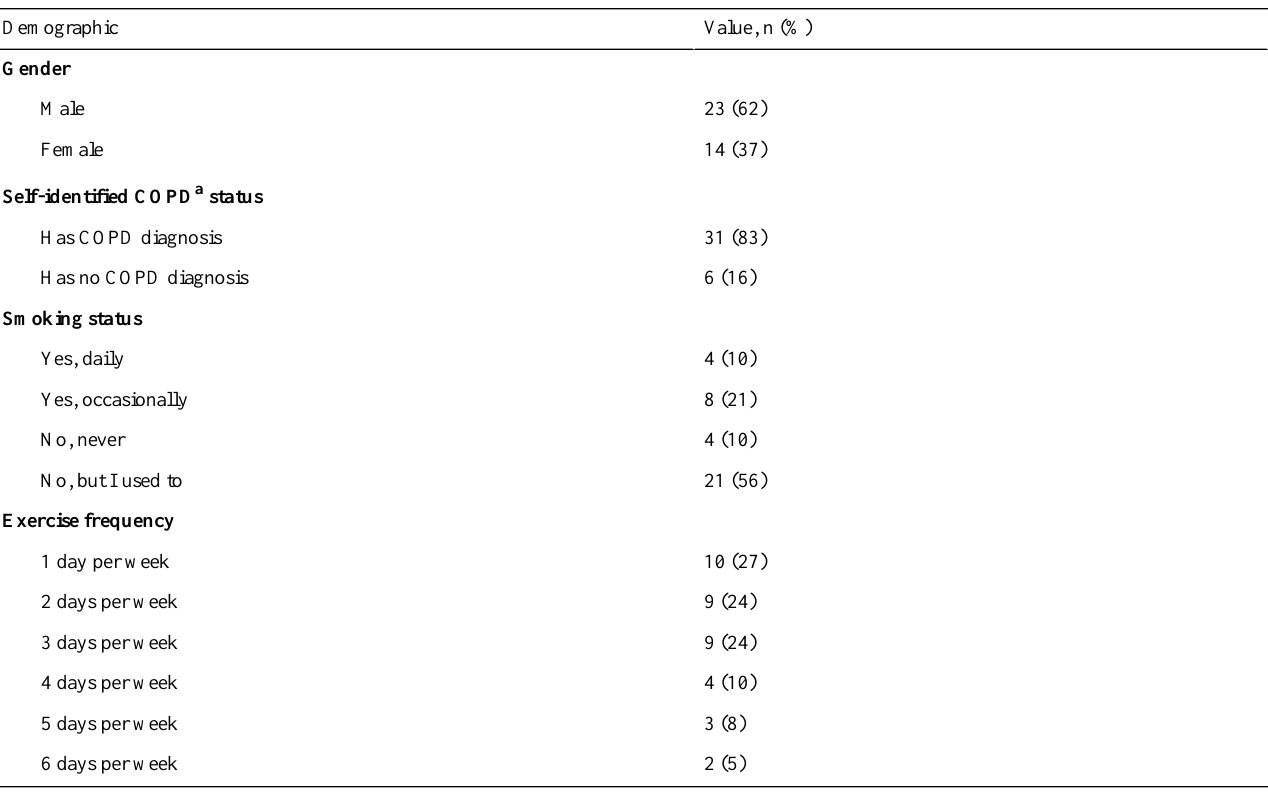
Table 1. Demographic data self-reported by participants (N=37).